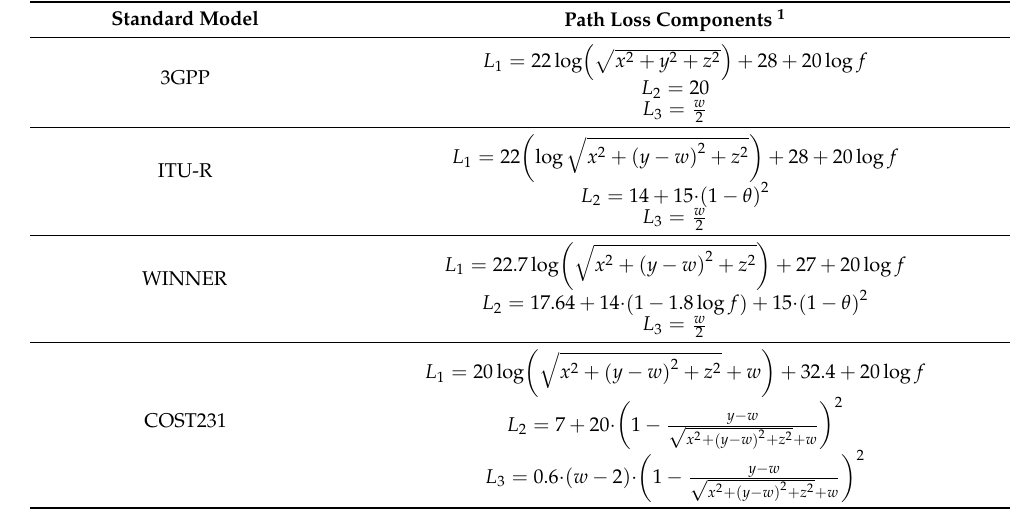
Table 5. Standard